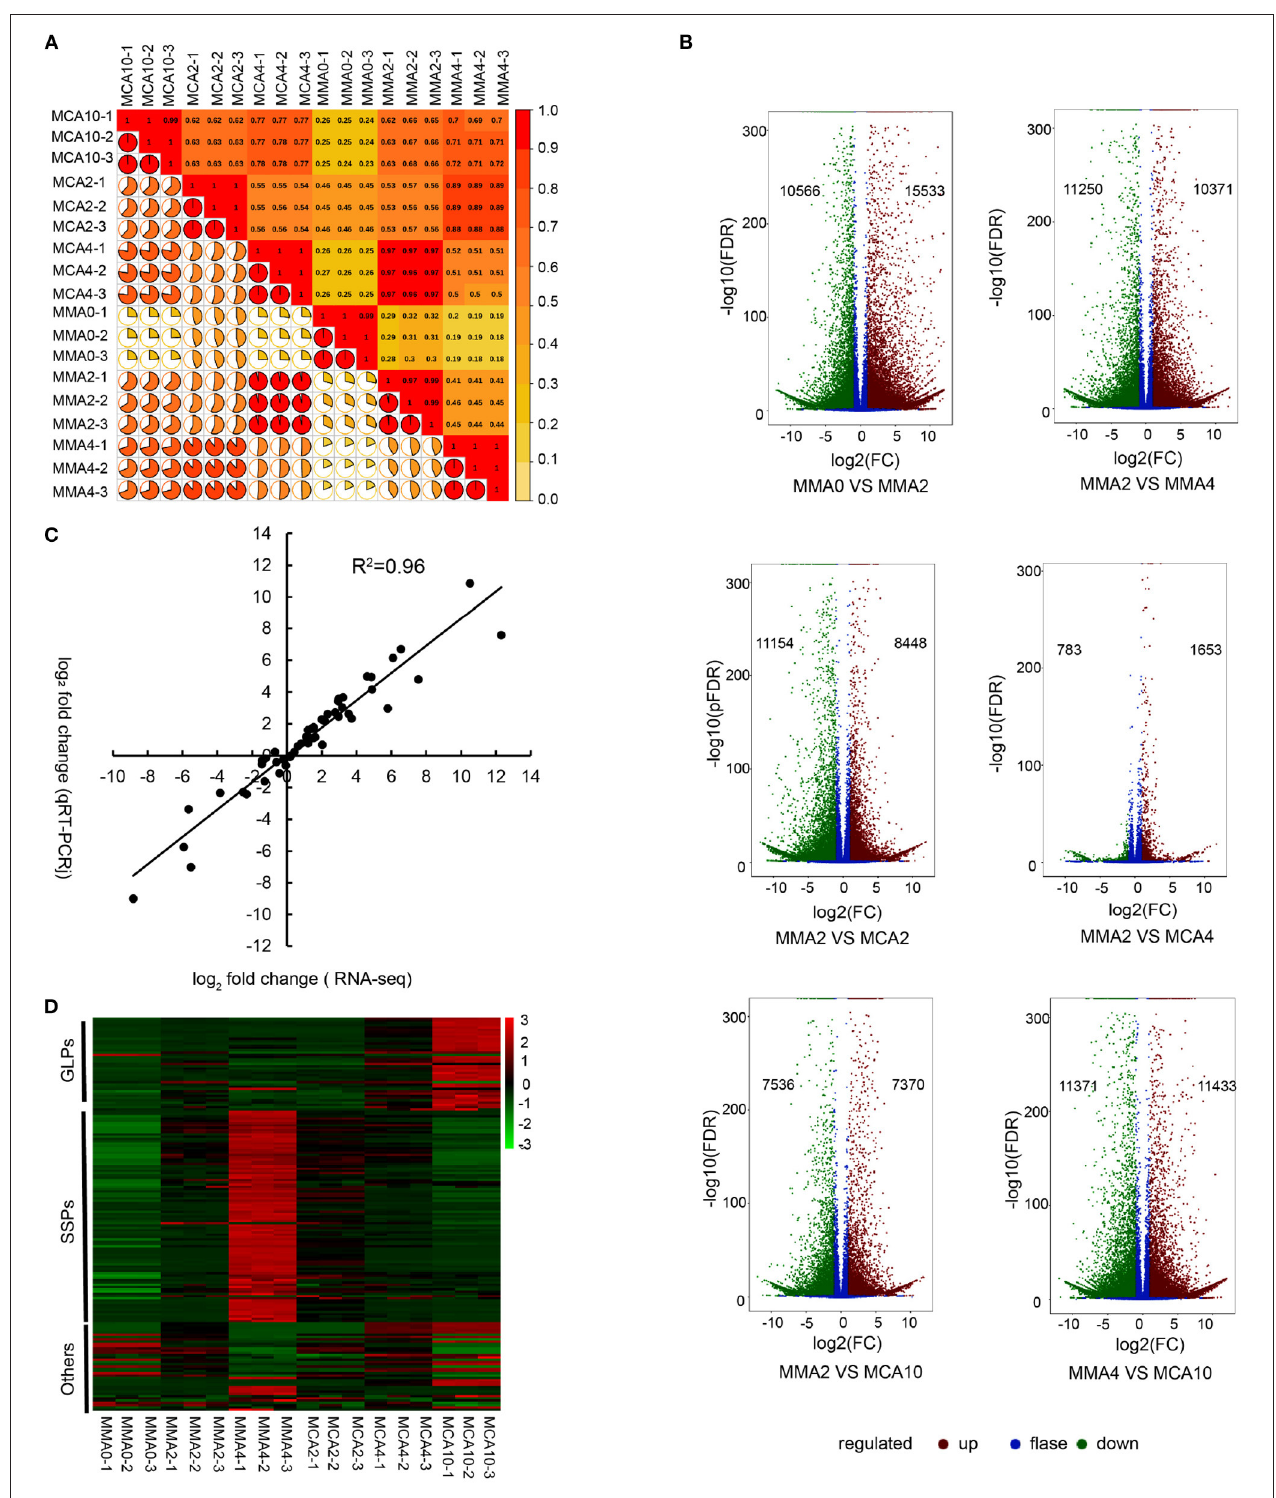
FIGURE 2 | Transcriptome analysis. (A) Heatmap of the Pearson’s correlation coefficient of different samples. (B) Volcano plot of DEGs of MMA0 vs. MMA2, MMA2 vs. MMA4, MMA2 vs. MCA2, MMA2 vs. MCA4, MMA2 vs. MCA10 and MMA4 vs. MCA10. (C) Comparison between the log 2 of gene expression ratios obtained from RNA-seq and qRT-PCR. (D) Expression of DEGs enriched in the GO term “nutrient reservoir activity.” GLPs, germin-like proteins; SSPs, seed storage proteins, mainly including albumin-like storage proteins, legumin-like storage proteins, and vicilin-like storage proteins; Others, other proteins, mainly including xylanase inhibitor C-terminal and xylanase inhibitor